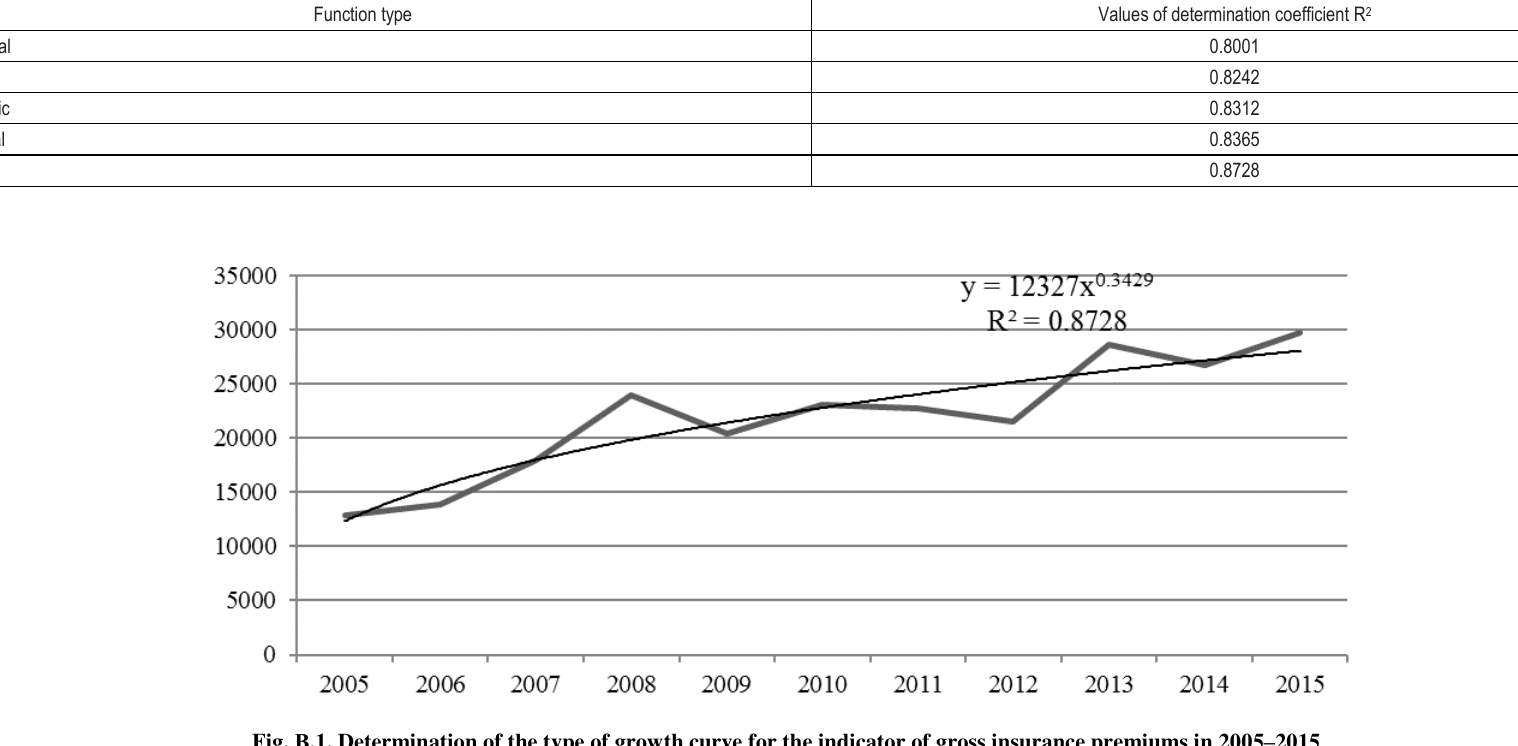
Fig. В .1. Determination of the type of growth curve for the indicator of gross insurance premiums in 2005 –